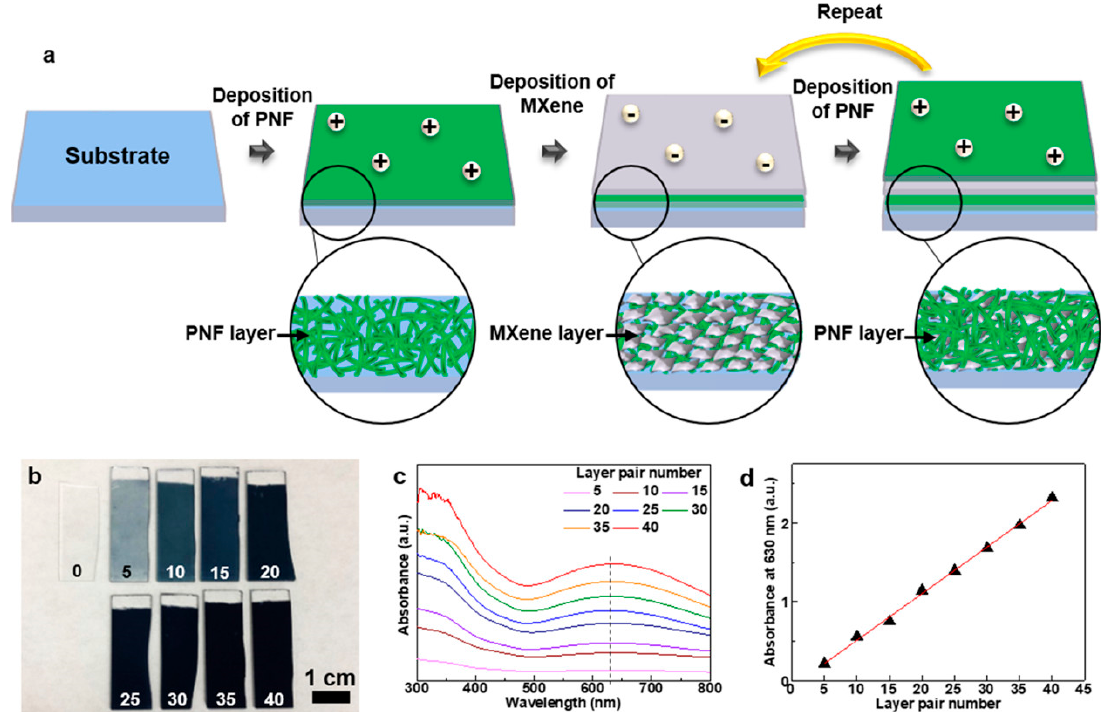
Figure 5. ( a ) Sketch of the assembly process of LbL multilayers obtained by alternate deposition of polyaniline nanofibers and MXene nanosheets. ( b ) Image of LbL films with different numbers of bilayers of polyaniline nanofibers and MXene nanosheets deposited on glass. ( c ) UV-Visible spectra for LbL multilayers of polyaniline nanofibers and MXene nanosheets with different numbers of bilayers. ( d ) Absorbance (at 630 nm) dependence on the number of bilayers for LbL multilayers of polyaniline nanofibers and MXene nanosheets. Reprinted with permission from Ref. [108] . Copy- right 2019 American Chemical Society.